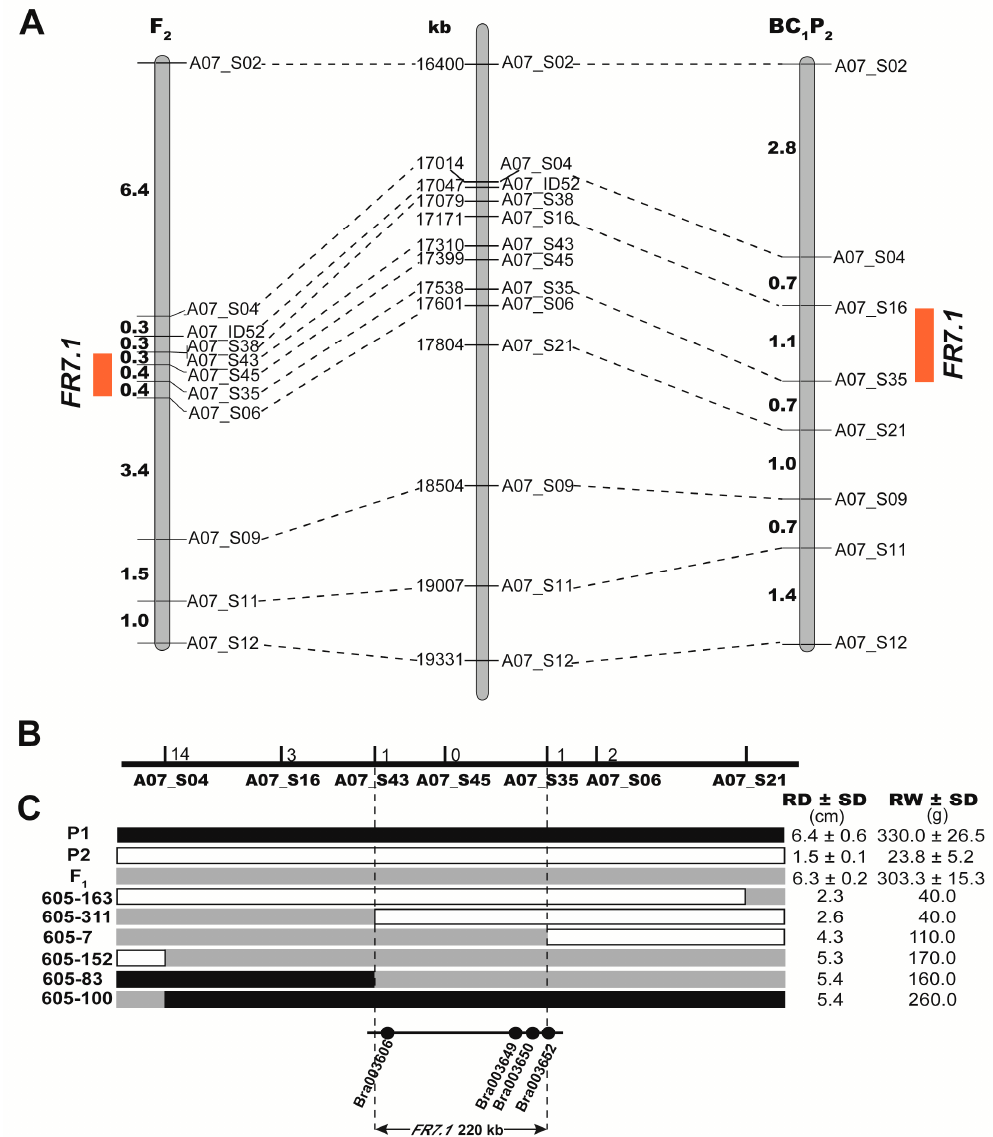
Figure 5. Mapping of the swollen root related quantitative trait loci (QTLs). ( A ) Locations of the FR7.1 (Fleshy root 7.1) locus on two linkage maps. The left and right linkage maps were constructed using F 2 and BC 1 P 2 populations, respectively. Numbers show the genetic distances between adjacent markers (cM), the red box denotes the QTL peak position. The map located in the middle of two linkage maps is a physical map of B. rapa A07 chromosome in the target region of the FR7.1 locus. Numbers show the physical distances; ( B ) Fine mapping of the FR7.1 locus in B. rapa . The numbers on the black line represent the number of recombinants at the corresponding markers; ( C ) Recombinants in the position of FR7.1 between SNP markers A07_S04 and A07_S21 (upper figure). RD: root diameter. RW: root weight. SD: standard deviation. The corresponding genes annotated according to the reference genome are presented in the 220 kb interval region (lower figure).